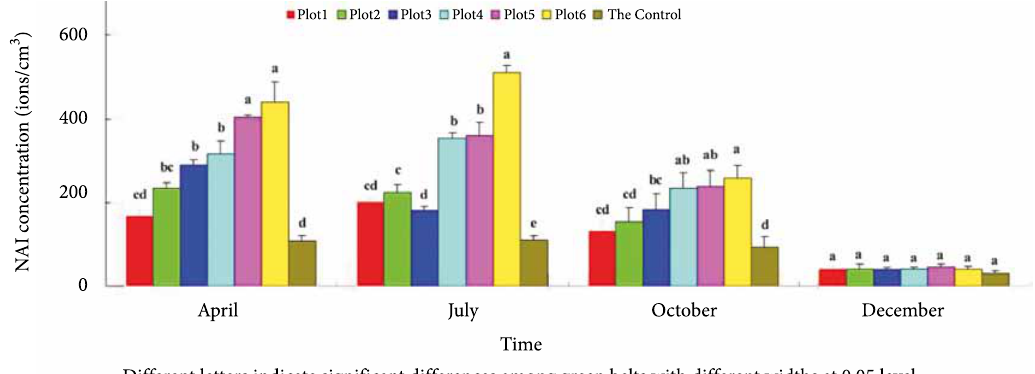
Fig. 11. The 3-day average of NAI concentration in the green belts